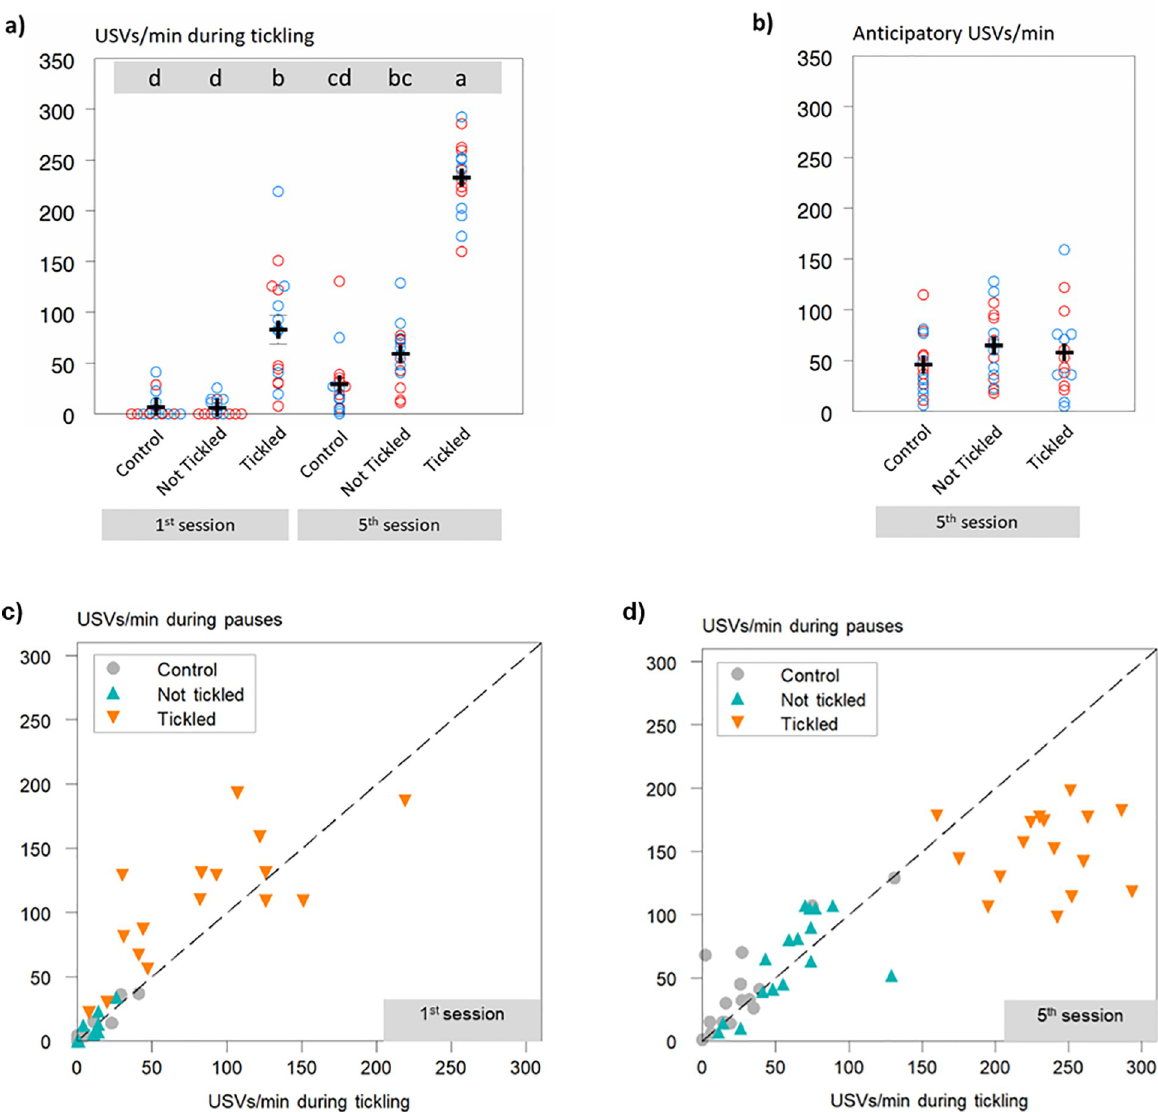
Fig 2. Ultra sonic vocalisations (USVs) across sessions. Data plot of 50 kHz USVs per minute for individual rats a) from the 1 st and 5 th sessions in the periods when tickling occurred for the Tickled rats; the Control rats and the Not Tickled rats were not tickled during these periods; and b) from the 5 th session from the 60 s period (anticipatory) prior to tickling; the Control rats and the Non-tickled rats were not tickled during the sessions that followed (red circles: odour A; blue circles: odour B). Means ( ± s.e.) are indicated with black plus symbols for each grouping; they differ significantly (P < 0.001) in a) if they do not share the same letter in the grey banner at the top of the figure. c) and d) : Data of 50 kHz ultrasonic vocalisations (USVs) per minute for individual rats during the pauses plotted against 50 kHz USVs per minute in the periods when tickling occurred for the Tickled rats for the 1 st and 5 th sessions, respectively; the Control rats and the Not Tickled rats were not tickled during these periods. The dashed lines indicate where y = x. odour B: 33.3%; H = 3.9; df = 1; P = 0.048). During the pauses, no significant differences between odours A and B were found across rat treatments in USVs emitted (86 ± 13.7 vs 83 ± 10.2 USVs/min, respectively; P = 0.856), nor during the anticipatory periods (57 ± 6.8 vs 56 ± 8.1 USVs/min, respectively; P = 0.808). Even after five tickling sessions, rats did not emit more anticipatory USVs when exposed to their tickling odour, compared to when exposed to their non-tickling odour and compared to